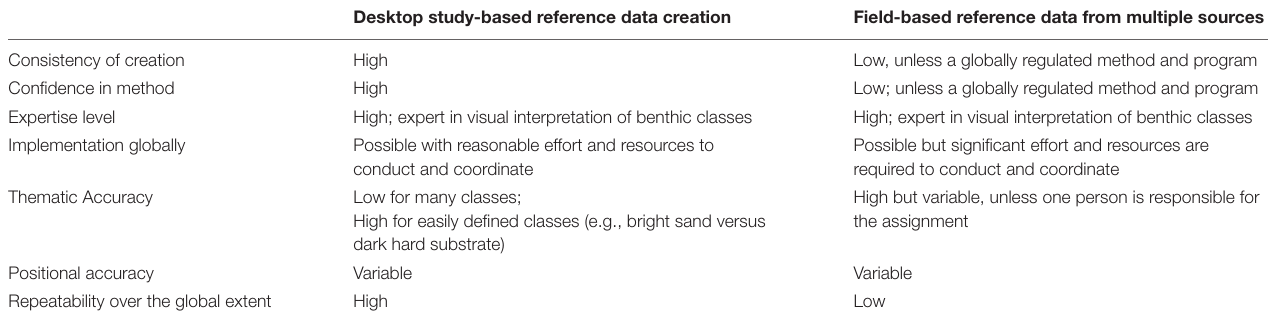
TABLE 1 | Contrasting the desktop study versus field-based reference data set